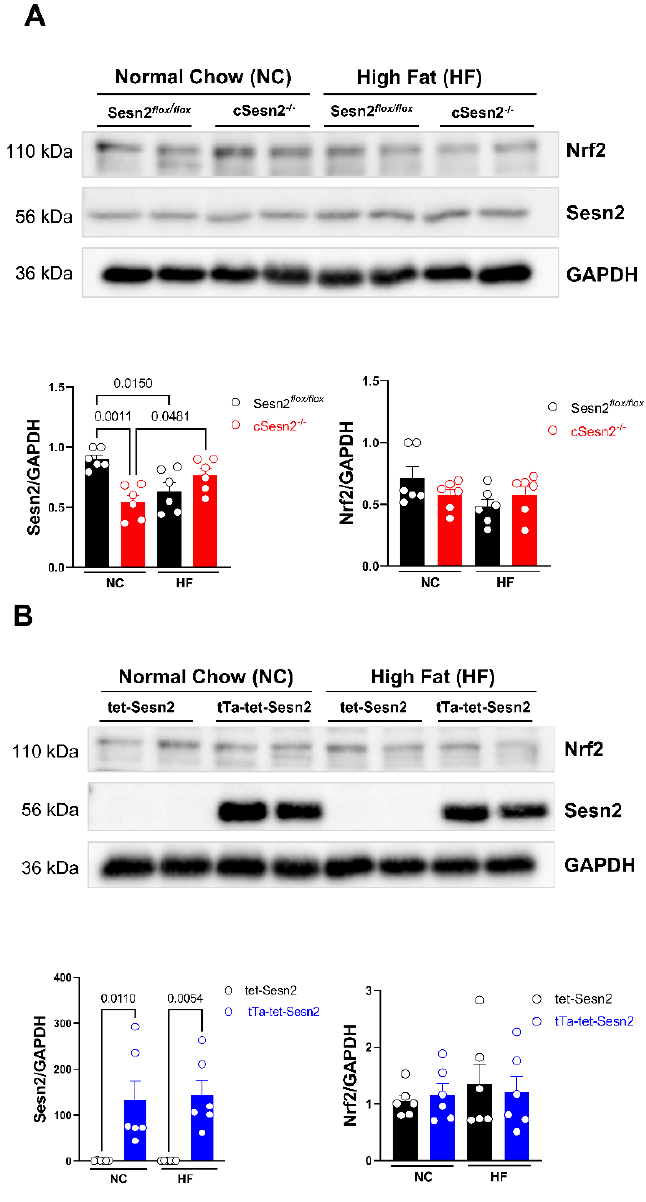
Figure 3. Western blotting results and representative images. Sesn2 and Nrf2 expression in ( A ) Sesn2 flox / flox and cSesn2 − / − and ( B ) tet-Sesn2 and tTa-tet-Sesn2 mice under NC and HF diets. Analysis is means ± SE. n = 6 per group.